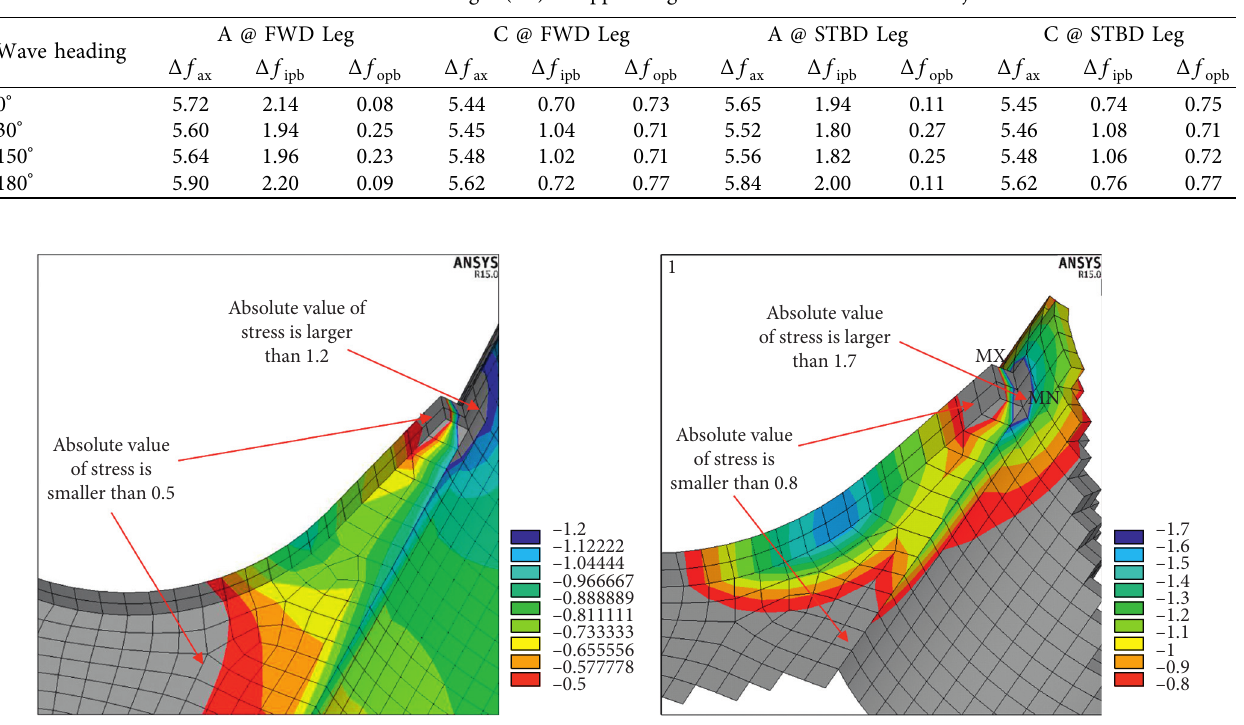
Table 5: Nominal stress ranges (ksi) of upper diagonal braces at the selected